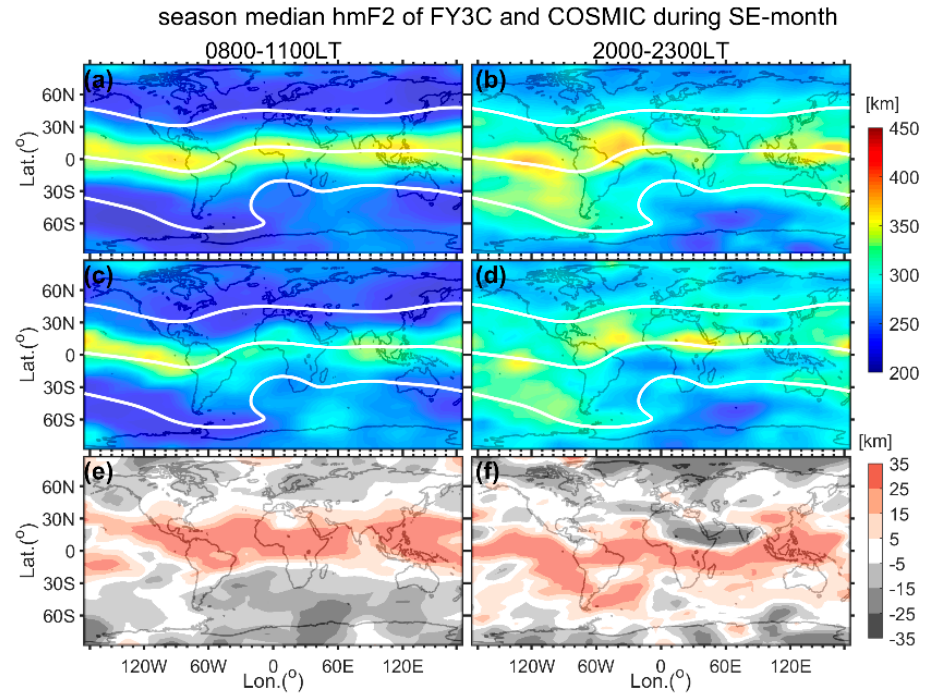
Figure 12. Ionospheric climatological characteristics of season median hmF2 observed by FY3C/GNOS and COSMIC and their differences at 0800–1100LT and 2000–2300LT during SE-month (2016.221–2016.311). Refer to Figure 10 for more detailed annotations.